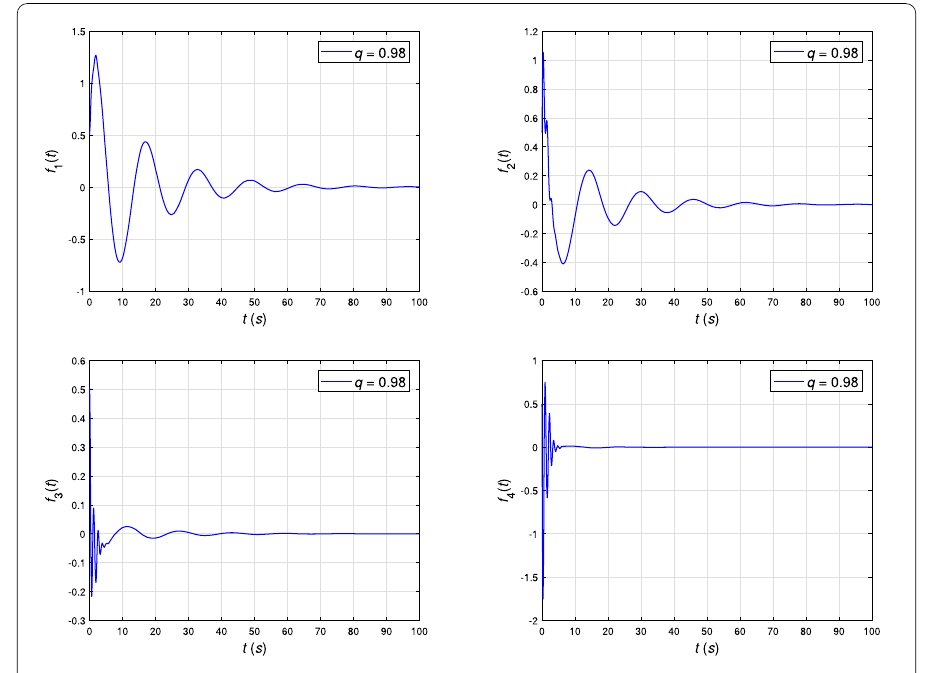
Figure 11 The time-domain responses of the controlled system (14) for q = 0.98